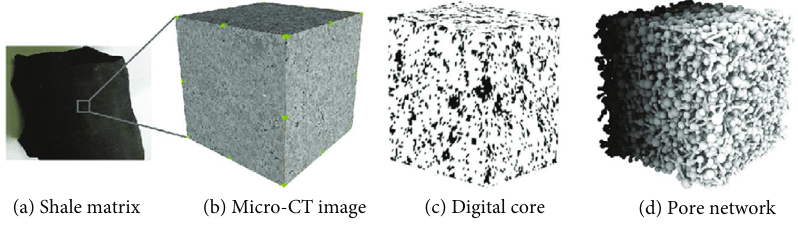
Figure 3: Real 3D pore network model